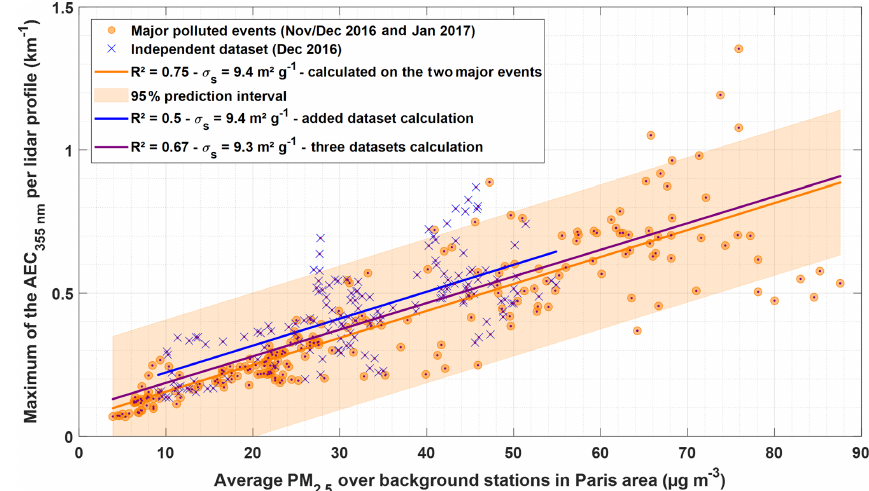
Figure 14. Relationship between PM 2 . 5 ( x axis) and AEC max within the PBL ( y axis). Orange dots are the same dataset presented in Fig. 13. The orange solid line corresponds to the linear regression computed from the orange points (same as Fig. 13) and the light orange area illustrates its 95% confidence interval. Blue crosses are data sampled from 3 to 10 December 2016. The blue solid line is the result of the linear regression calculated on this independent dataset. The purple solid line is the result of the linear regression calculated on all the points (blue crosses and orange dots). The correlation coefficients can be found in the top left-hand